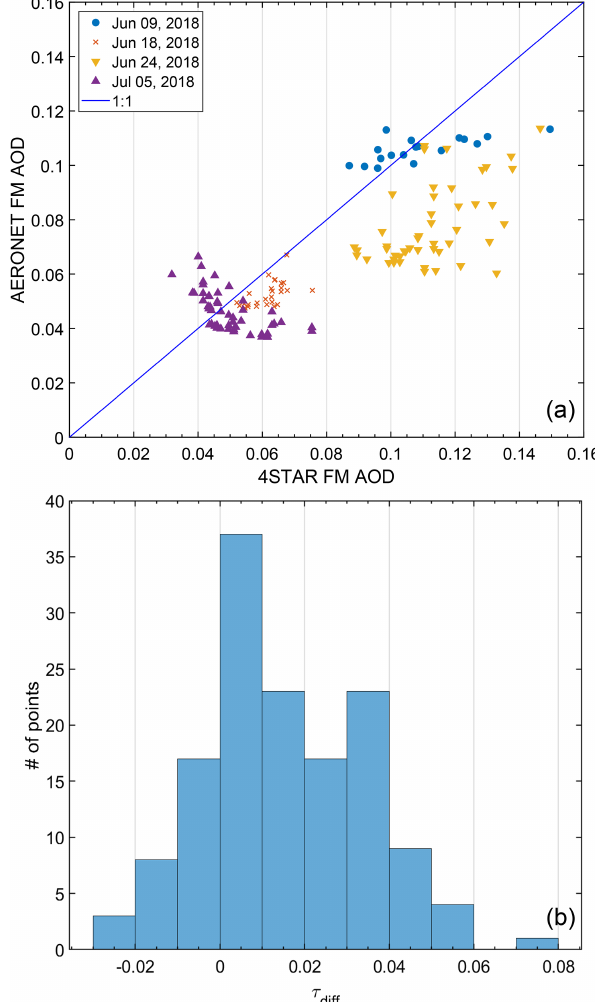
Figure 9. (a) AOD fine-mode comparisons between 4STAR and AERONET for the selected flights of 9, 18 and 24 June and 5 July. (b) Corresponding histogram of fine-mode AOD differences be- tween the 4STAR and AERONET. AERONET data were matched with 4STAR within 10min. 4STAR data include only out-of-plume AODs acquired during a straight-level flight (i.e. excluding spirals) at an altitude of less than 1km. For 24 June the AERONET data after 18:13 were removed because they were associated with forest